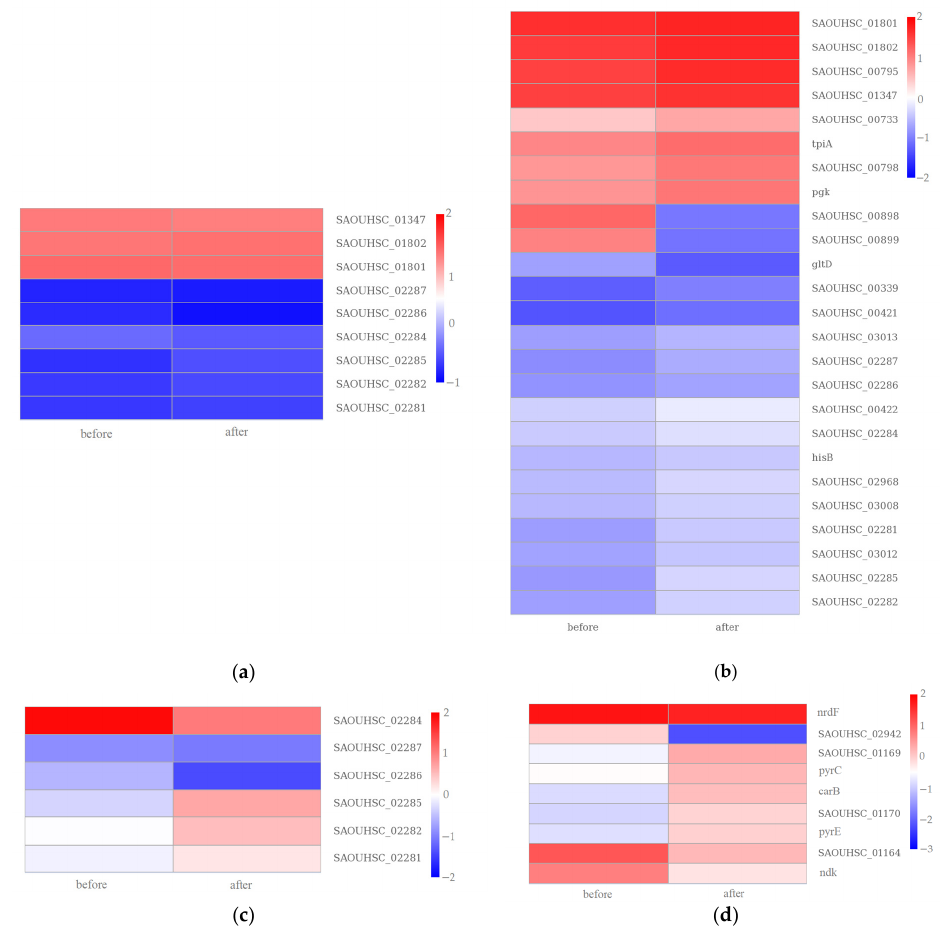
Figure 7 . Transcriptional changes in the KEGG pathway related to ( a ) “2-oxocarboxylic acid metabolism”, ( b ) “biosynthesis of amino acids”, ( c ) “valine, leucine, and isoleucine biosynthesis”, and ( d ) “pyrimidine metabolism” in CHPC 1.8487 after the chlorine-containing disinfectant treatment.